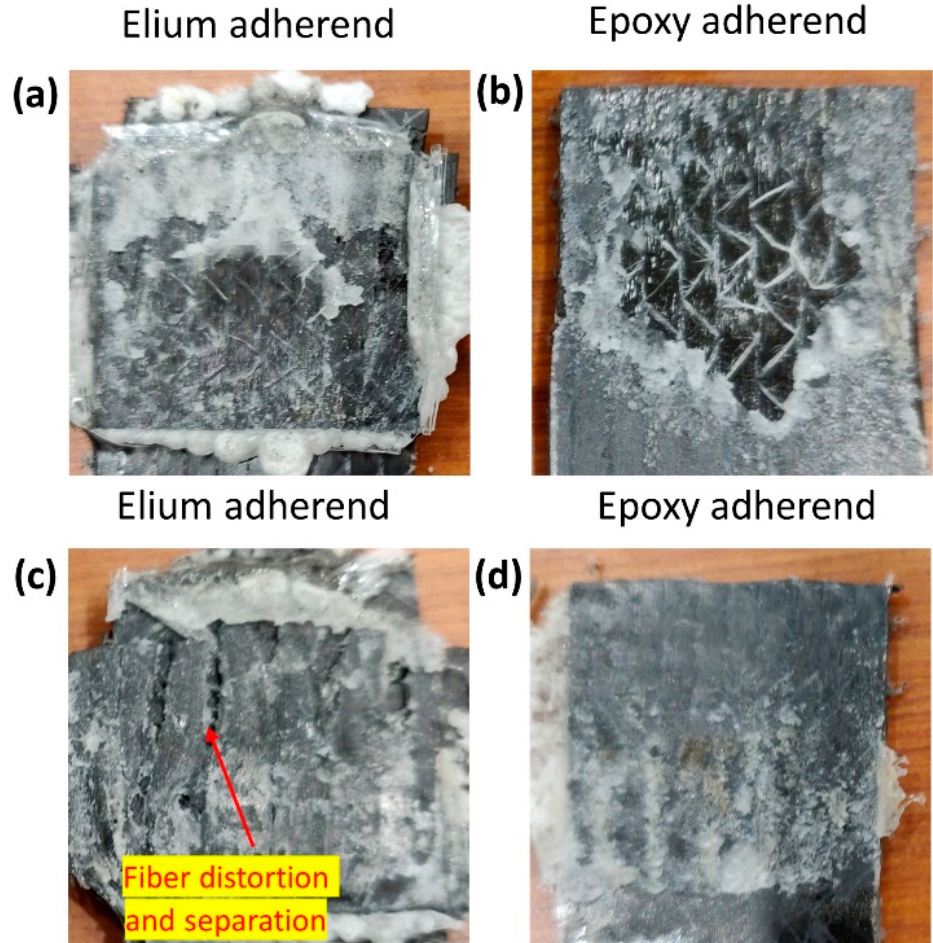
Figure 8. Fracture surfaces of EL-EP(Elium ® - Epoxy)_0.125_0.125. ( a , b ) Maximum Lap shear strength and ( c , d ) minimum Lap shear strength.